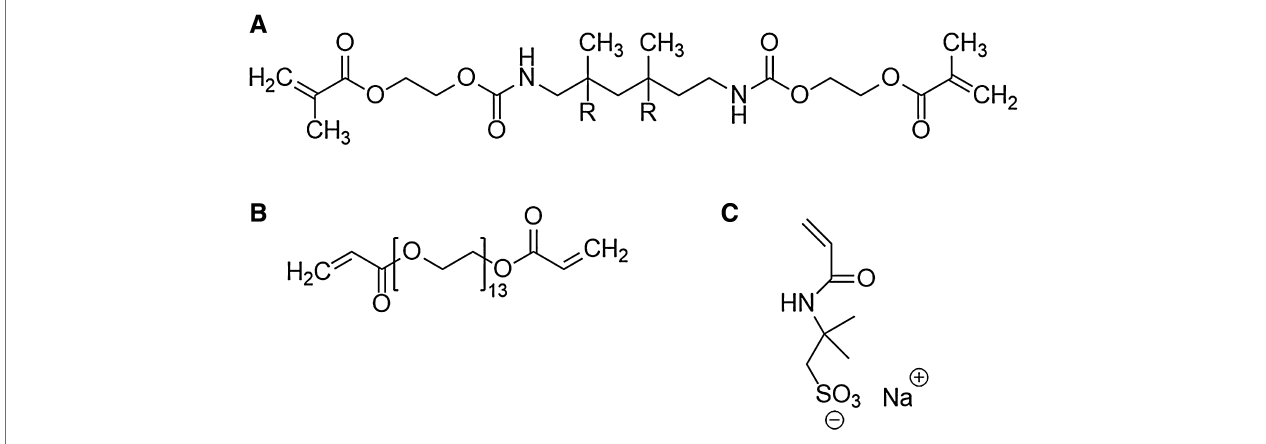
FIGURE 1 | Chemical structures of the oligomers and ionic species used in this study: (A) diurethane dimethacrylate, (B) polyethylene glycol diacrylate, and (C) 2- Acrylamido-2-methyl-1-propanesulfonic acid sodium salt.